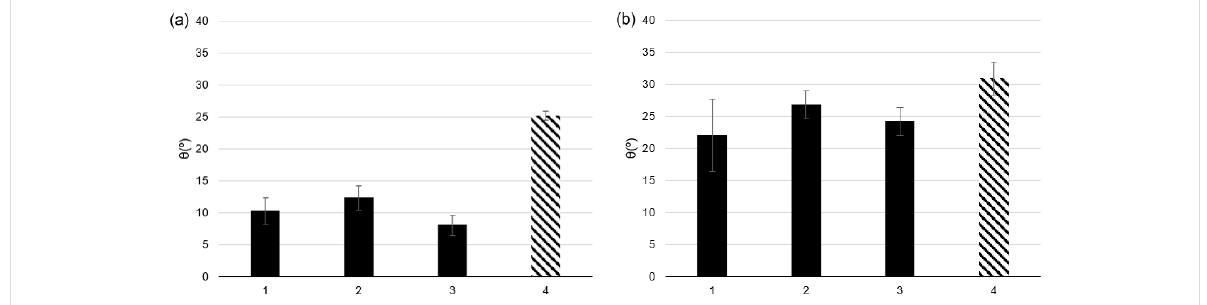
Figure 4: Contact angles of (a) humid and (b) dry PEG + [BMIM][DCA] (1), PEG + [BMIM][TfO] (2), PEG + [EMIM][TfO] (3), and PEG (4) on silicon substrates. The error bars correspond to standard deviations ( n ≥ 7).